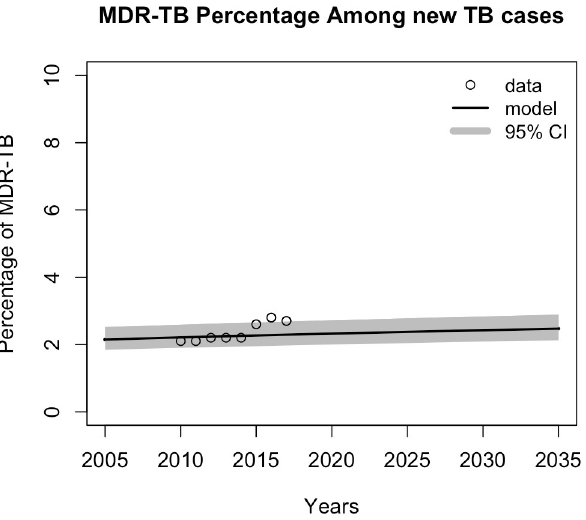
Fig 3. Model projection of estimated MDR-TB percentage among new TB cases. The black line shows the model results of percentage of MDR-TB cases, and the dots represent WHO data for the estimated proportion of MDR-TB among new tuberculosis infections.